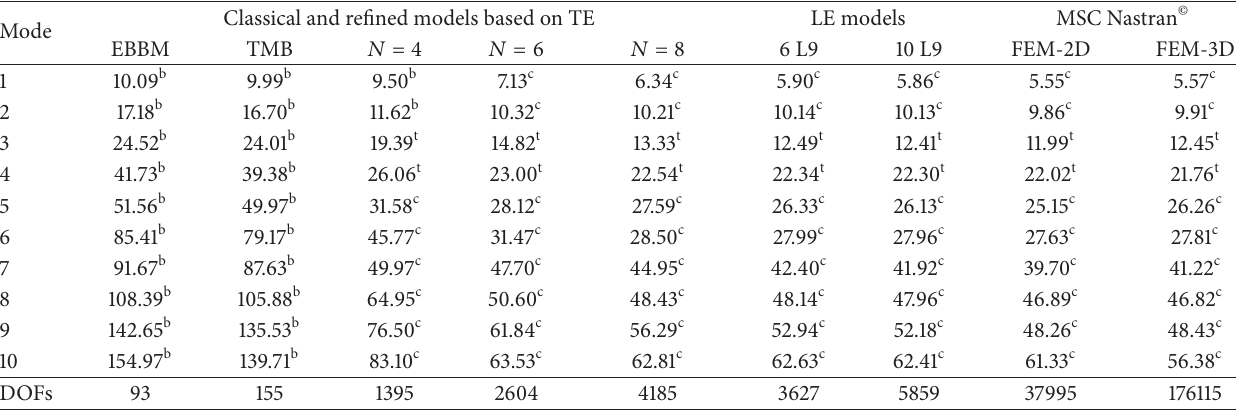
Table 3: First 10 natural frequencies (Hz) for the clamped-clamped C-shaped beam with localized inertia at 𝑦 = (3/4)𝐿 (Figure 9). Mode